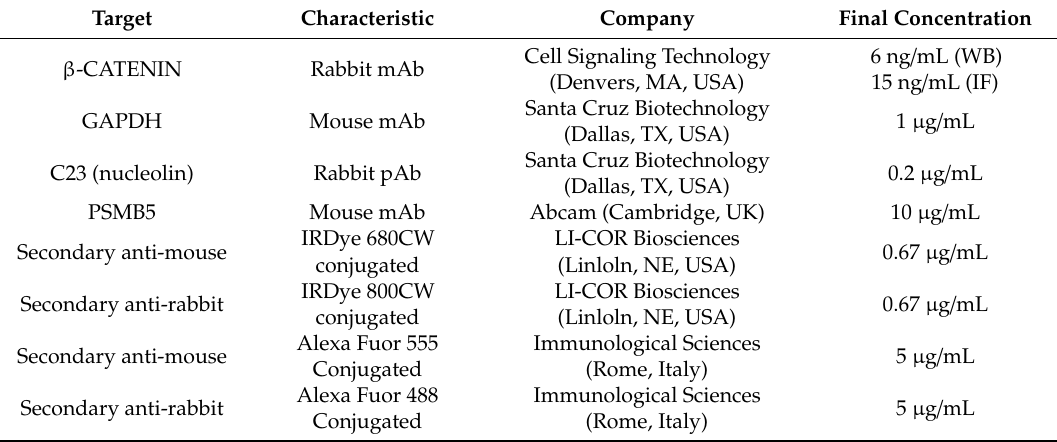
Table 4. Primary and secondary